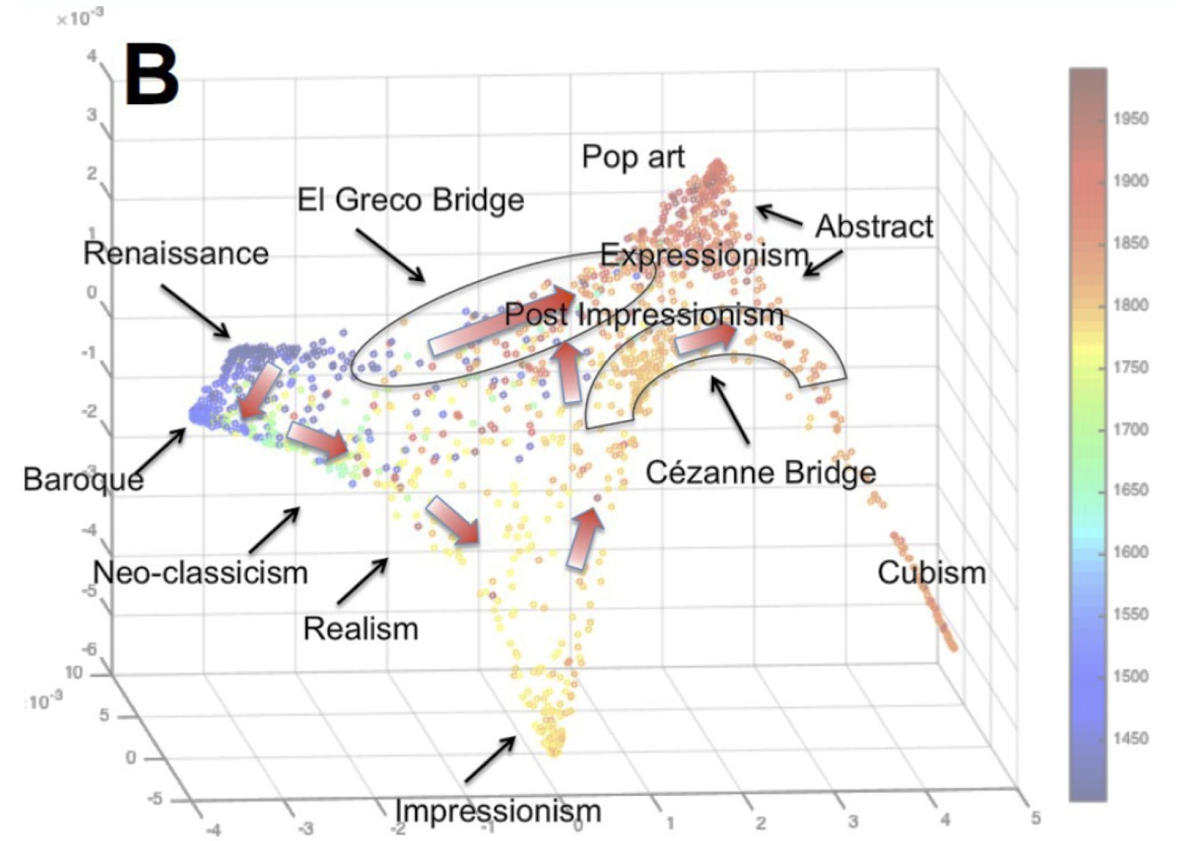
Figure 12. Evolution of Western pictorial production projected in a three − dimensional manifold. A. Elgammal et al. The shape of Art History in the Eyes of the Machine. arXiv: 1801.0772 2018 (Figure 8b).